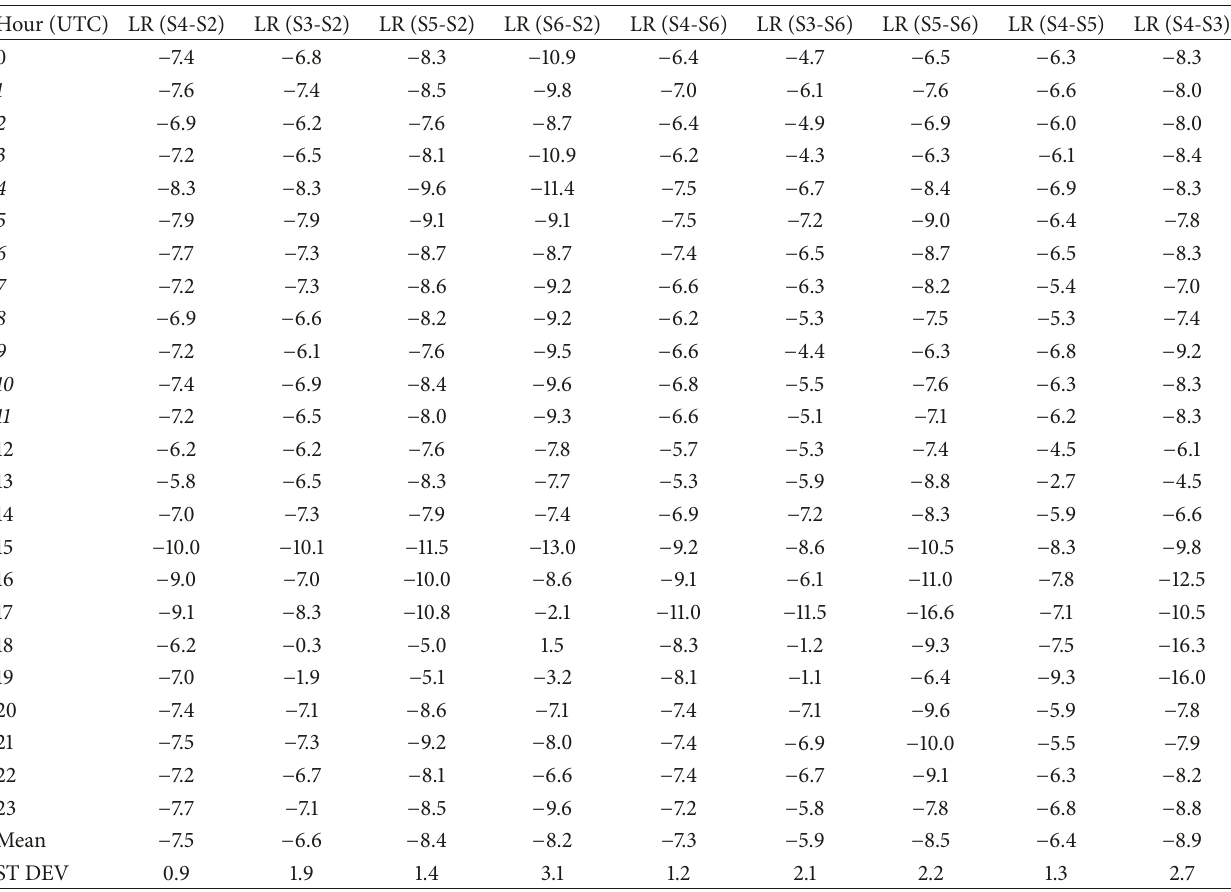
Table 3: Comparison of mean hourly lapse rate data ( ∘ C km −1 ) for 22–26 March 2015 at the five Tinytag sites (2-m sensors). See Figure 1 and Table 1 for site details. Hours with nocturnal observations are highlighted in italic (https://www.timeanddate.com/sun/chile/santiago), here illustrated in UTC.